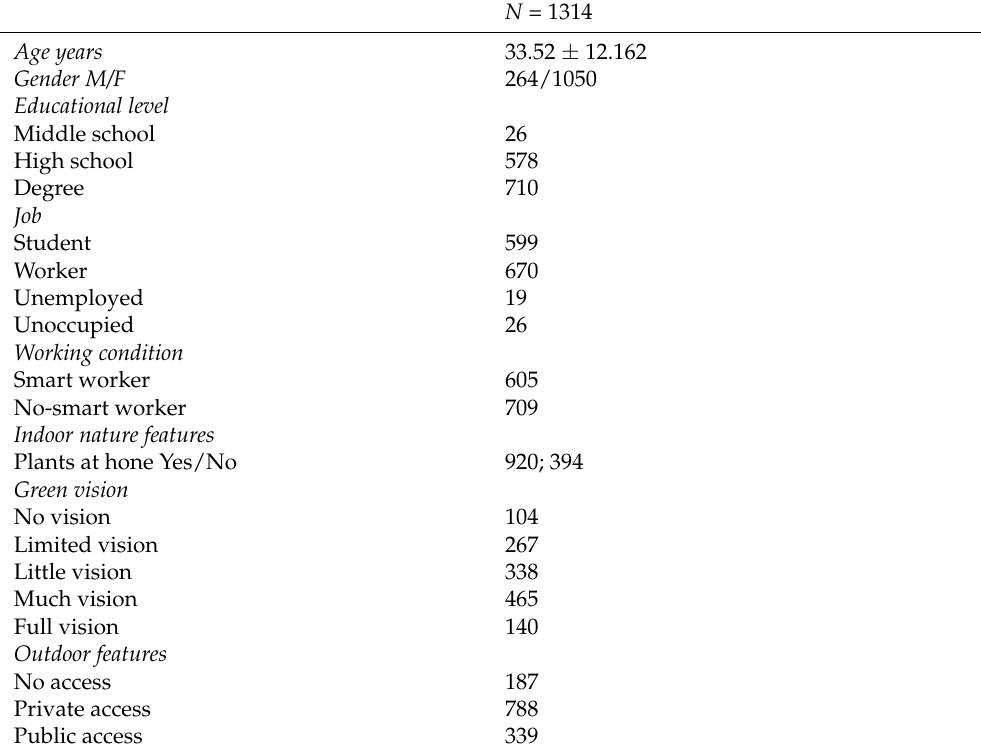
Table 1. Sociodemographic characteristics and data distribution for indoor and outdoor greenery features.